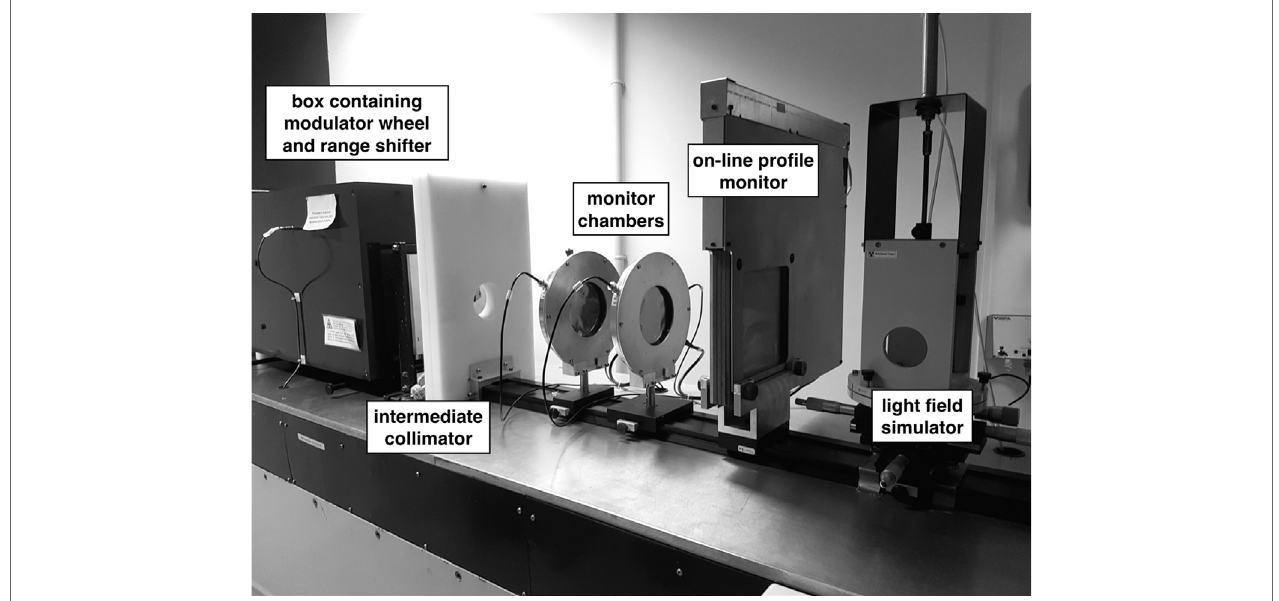
FIgURe 1 | Central section of the CATANA proton therapy beamline with some transport (collimators, modulators, and range shifters) and diagnostic (monitor chambers, on-line profile monitoring, and field simulator).